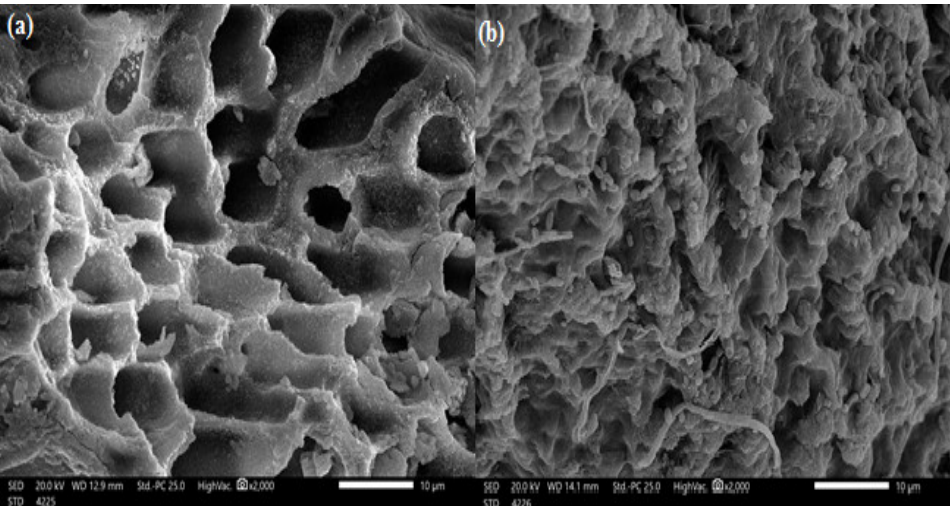
Figure 3. Scanning electron microscope of Sargassum latifolium at ( a ) before and ( b ) after adsorption of methylene blue